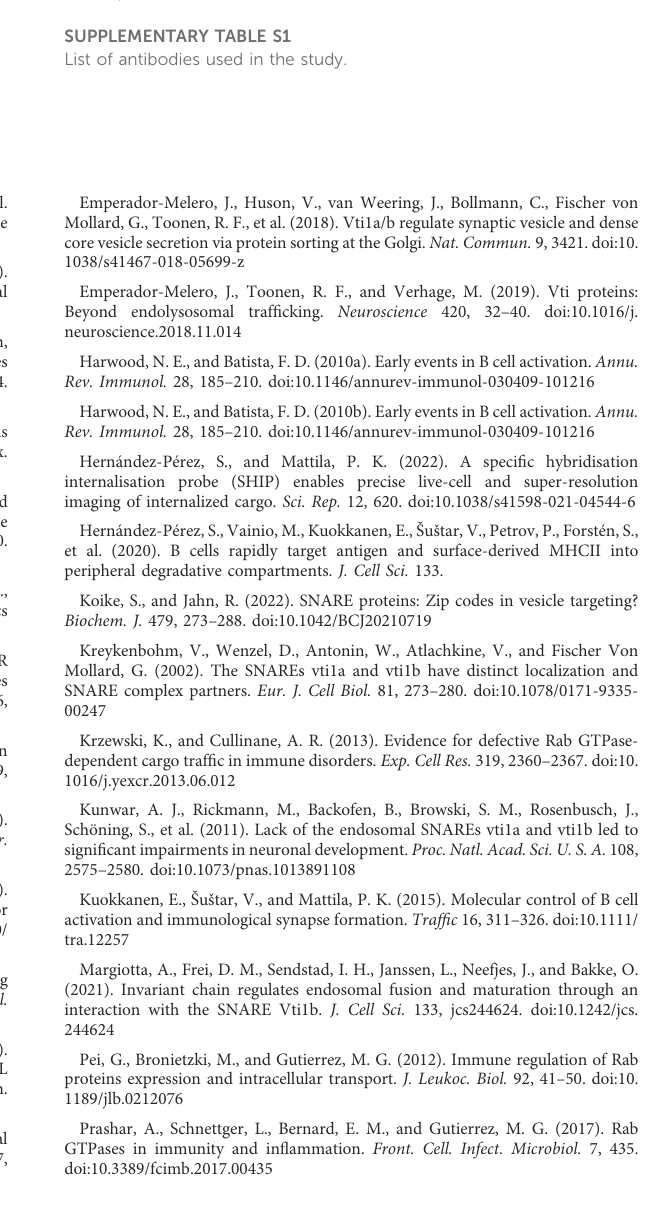
with anti-Rab6, Rab7 or Rab11 (magenta) and phalloidin (actin; yellow). Scale bar: 5 µm. SUPPLEMENTARY FIGURE S3 (A) Surfacelevelsofanti-IgMBCRinnon-stimulatedprimarycellsisolated from the spleen of Vti1b HEZ or KO mice. (B) Cell Trace Violet (CTV) labelled OT-II T cells were incubated with WT, HEZ or Vti1b KO B cells activated with anti-IgM or anti-IgM:OVA (2 different ratios) coated beads for 3 days. After 3 days, T cell proliferation in response to OVA peptide presentation is measured by fl ow cytometry.